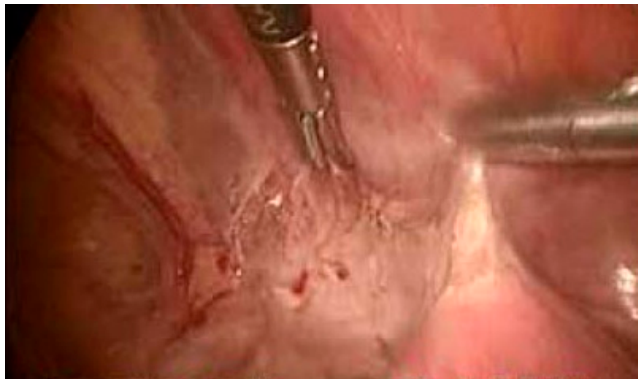
Figure 3. The bladder was released from a gestational sac.